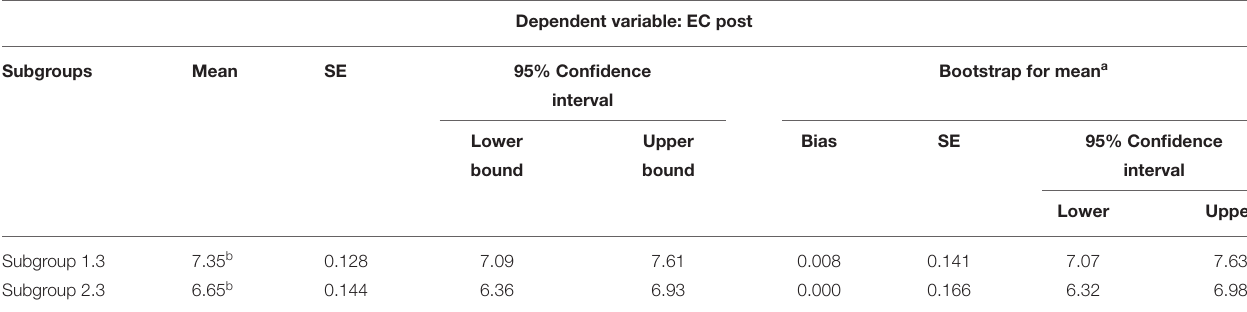
TABLE 9 | ANCOVA estimated means for